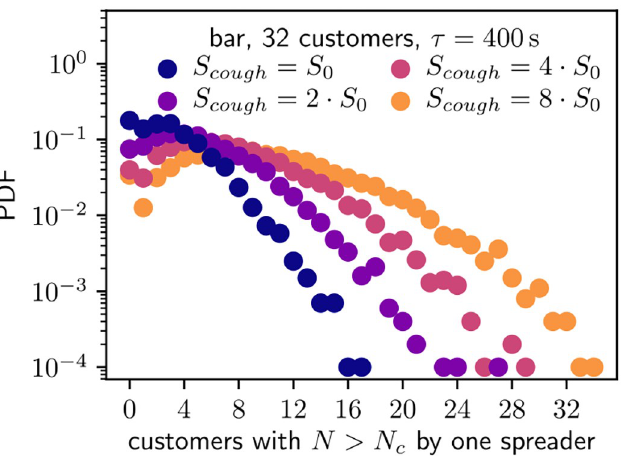
Fig 6. Distribution of the number of customers with critical exposure N > N simulations with 32 customers and τ = 400 s. Here the amount of emitted aerosols during a cough is varied from S 0 = 40000 to 8 � 40000